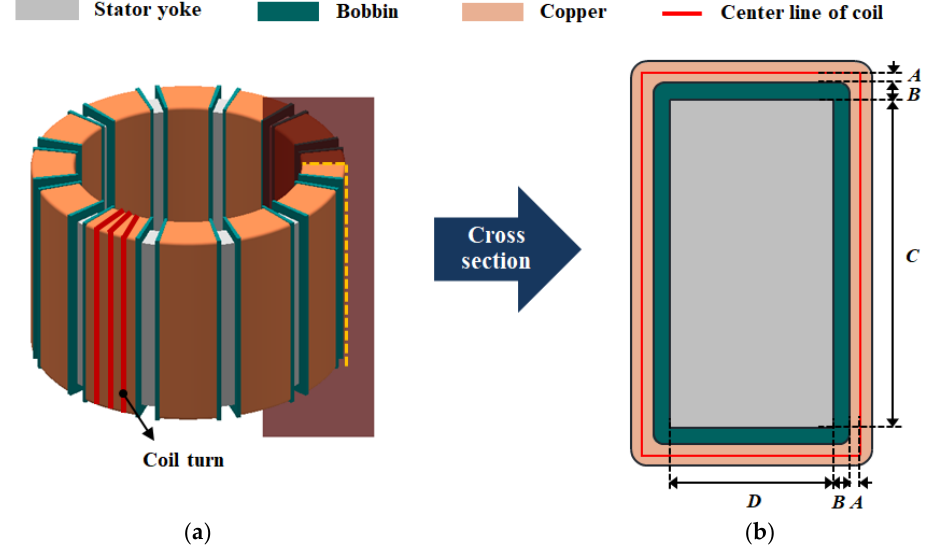
Figure 9. Structural diagram of the toroidal coil for resistance calculation: ( a ) 3D Armature coil, and ( b ) Cross-section of toroidal coil.